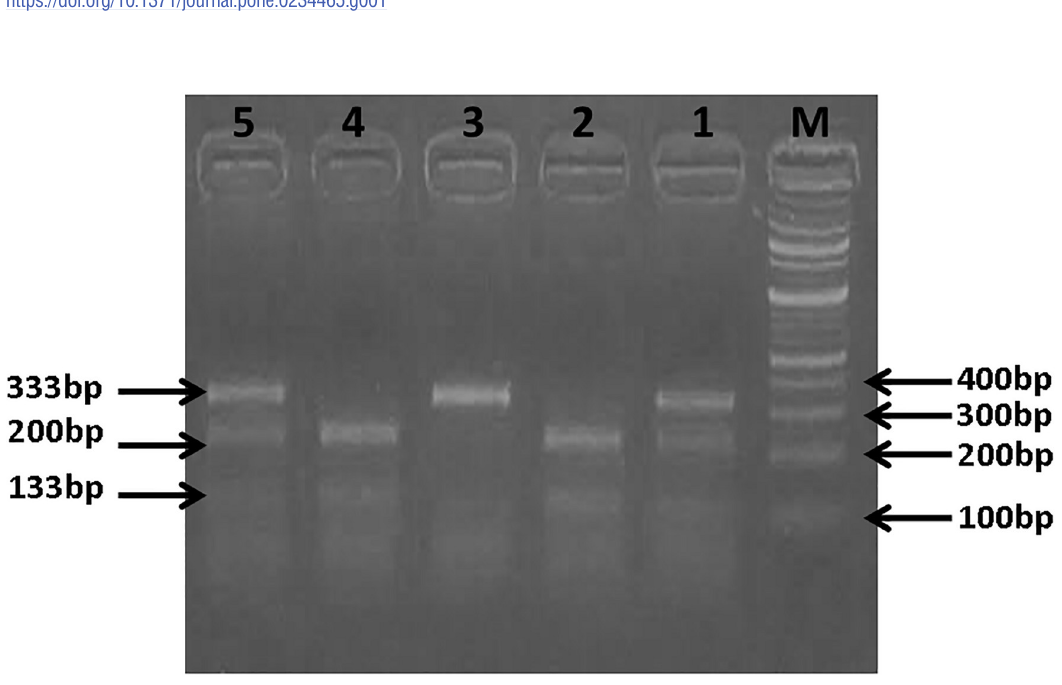
Fig 2. Analysis of PNPLA3 gene (rs738409) C > G polymorphism: A representative agarose gel picture showing PCR-RFLP analysis of PNPLA3 gene (rs738409) C > G genotypes in genomic DNAs of study subjects with restriction endonuclease enzyme BstF5 I. M: (100 bp—1.5 kb) DNA ladder, Lane 1 and 5: CG heterozygous (333 bp, 200 bp and 133bp), Lane 2 and 4: CC homozygous (200 bp and 133 bp) and Lane 3: GG homozygous (333 bp).